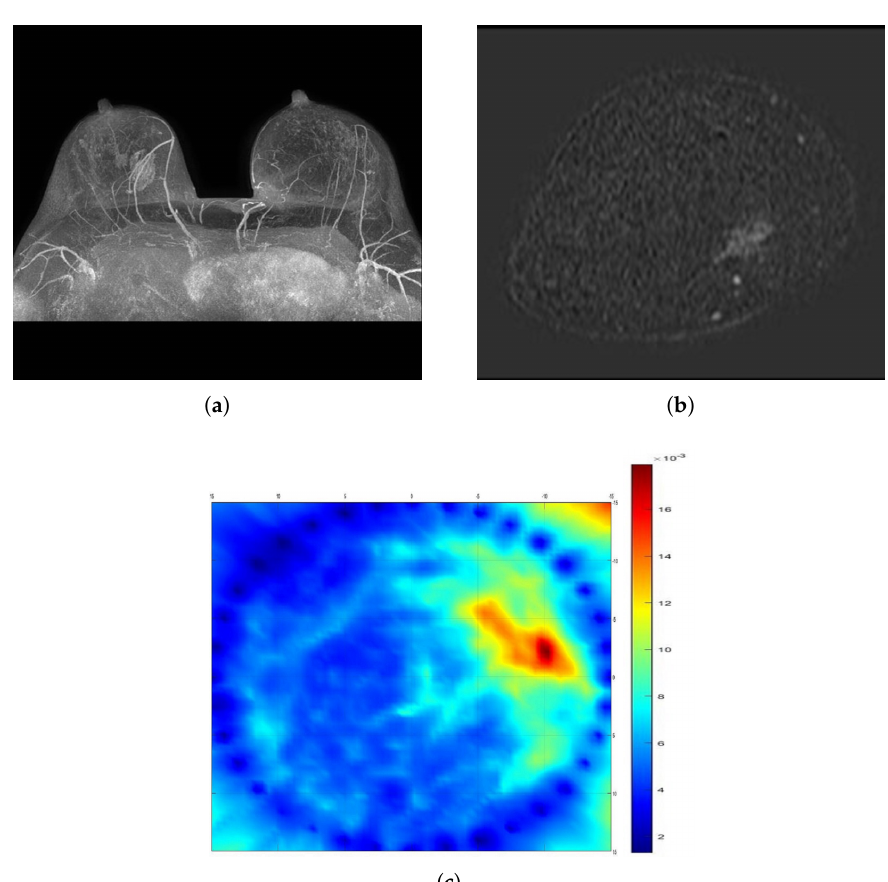
Figure 2. Comparison of SAFE lesion detection with clinical MRI: ( a , b ) MRI scans showing benign lesion in the right breast (axial and coronal planes), and ( c ) SAFE scan showing the concordance with MRI (coronal plane).